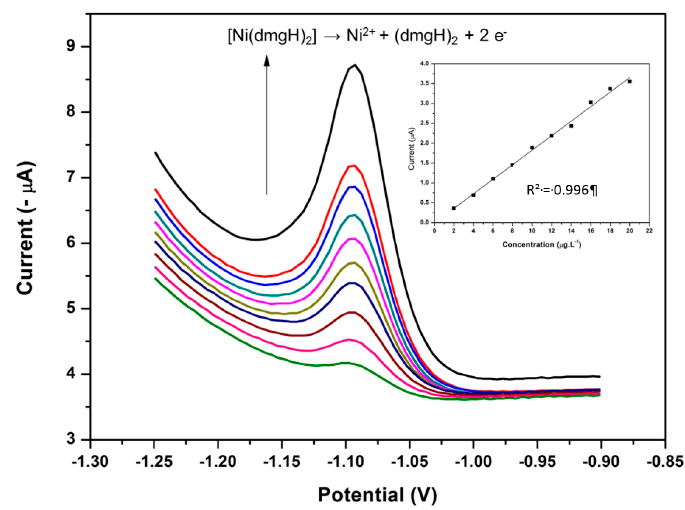
Figure 17. SWAdSV and corresponding calibration plot of the individual analysis of Ni 2+ in the presence of Co 2+ and Zn 2+ obtained at a NGr-DMG-GCE over 2–20 µ g L − 1 . Supporting electrolyte (0.1 M NH 3 /NH 4 Cl Buffer (pH 9.3)), deposition potential ( − 0.7 V), deposition time (120 s), frequency (20 Hz), amplitude (0.02 V) and voltage step (0.005 V). Table 2. A summary of selected previously reported (a) chemically modified DMG and (b) in-situ DMG sensors for adsorptive stripping voltammetric detection of Ni 2+